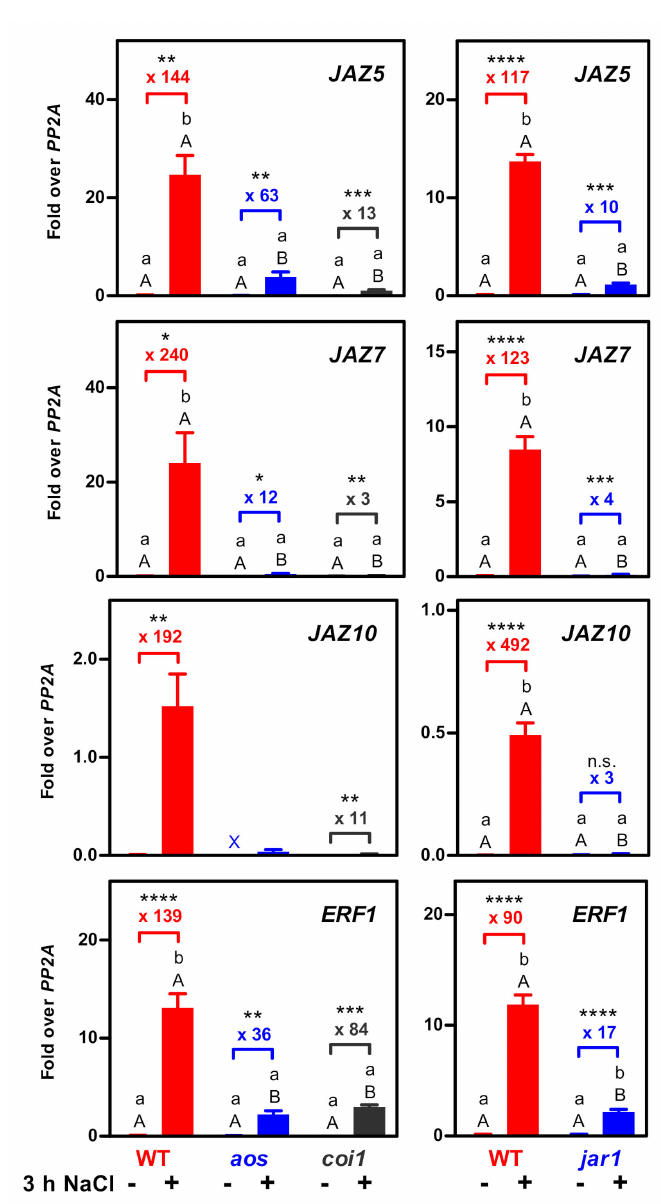
Figure 3. Quantitative RT-PCR analysis of JAZ5 , JAZ7 , JAZ10 and ERF1 transcript levels in root material of the indicated genotypes after three hours of either control or NaCl treatment. Relative transcript levels were determined using PP2A as a reference gene. The mean values ( ± SEM) obtained from three to five individually harvested plants are shown. The JAZ10 value for the control treatment of aos plants (marked with a cross) was obtained from one sample only; the other values were below the detection limit. Numbers indicate fold change values after salt treatment and asterisks denote statistical significance when each genotype was examined separately (unpaired, two-tailed t -test. * p < 0.05; ** p < 0.01; *** p < 0.001; **** p < 0.0001; n.s., not significant). Overall statistical analysis was done using a two-way ANOVA followed by Bonferroni’s post-test: uppercase letters indicate significant di ff erences ( p < 0.05) between genotypes subjected to the same treatment; lowercase letters indicate significant di ff erences ( p < 0.05) between control and NaCl treatments performed with the same genotype. In a previous study, JAZ genes had been shown to be significantly induced in salt-treated coi1 and -2 roots, with background and induced transcript levels both being lower than in wild-type plants [23]. These results might suggest that COI1 would constitutively enhance basal and induced gene